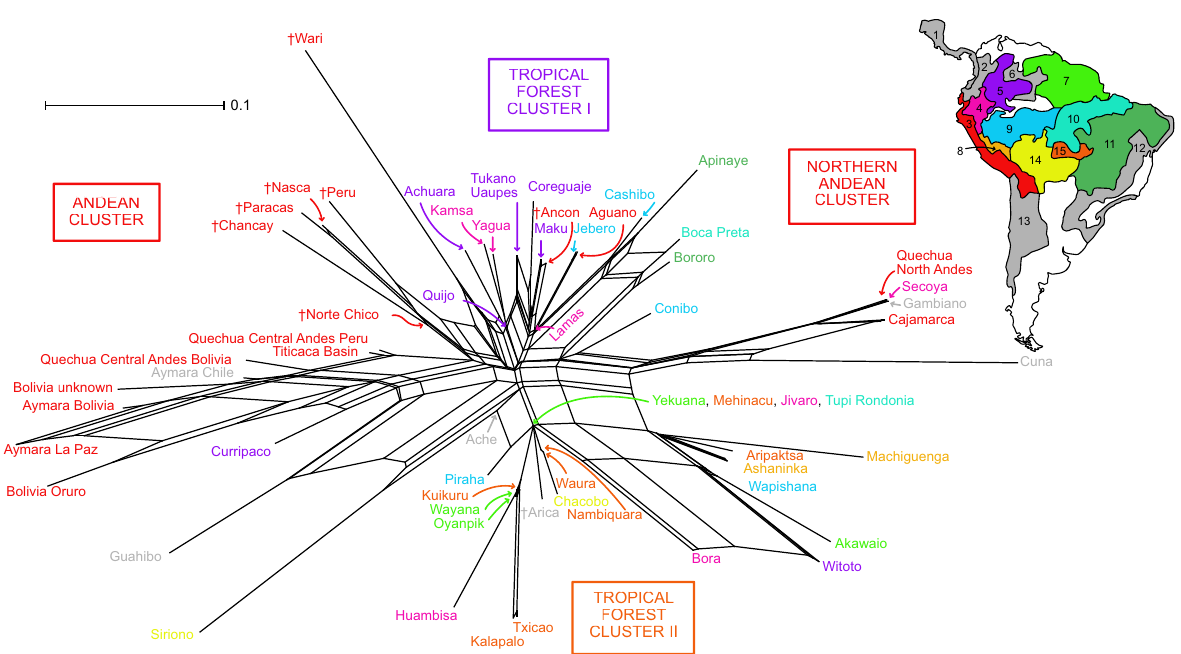
Fig. 6 A neighbor-net constructed from the concatenation of 13 panpipe features discretized in 53 character states for 61 societies, based on observations of 375 panpipes. The colours relate to the cultural areas described by Murdock (1951), as illustrated in the map: (1) Isthmian; (2) Colombian; (3) Peruvian; (4) Loreto; (5) Caqueta; (6) Savanna; (7) Guiana; (8) Montaña; (9) Jurua-Purus; (10) Pará; (11) Goiás; (12) Eastern lowland; (13) Chilean; (14) Bolivian; and (15) Xingú. The scale bar illustrates the distance among